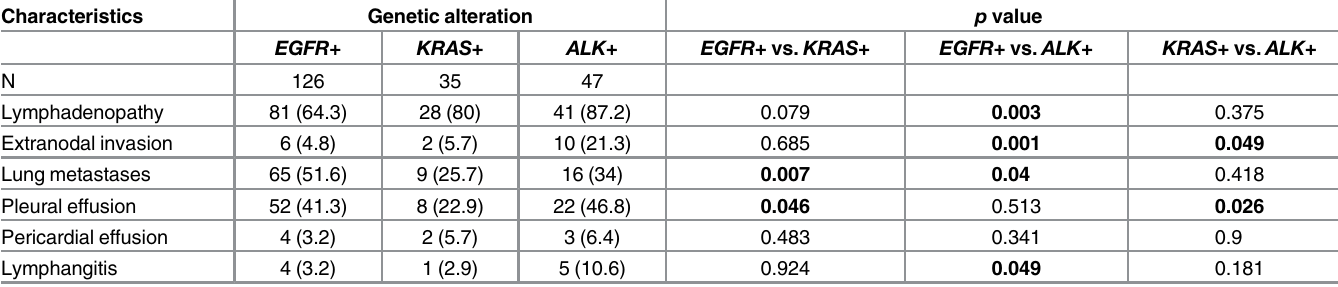
Table 3. Imaging characteristics of the intra-thoracic findings in stage IIIB – IV patients with lung adenocarcinoma.